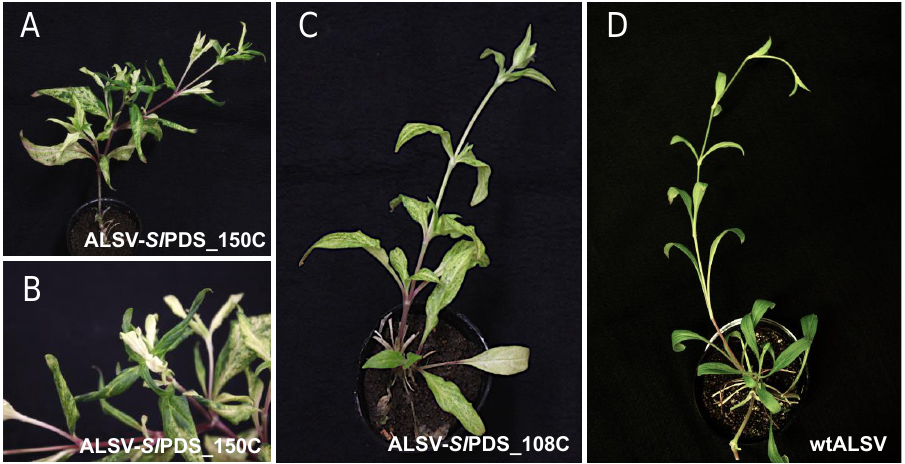
Figure 4. ( A ) Systemic phenotype of the plant infected with ALSV- Sl PDS_150C and ( B ) enlarged image of the shoot apex in ( A ). ( C ) The plant infected with ALSV- Sl PDS_108C and ( D ) wild-type ALSV. Bars = 10 cm (single line), 2 cm (double line).